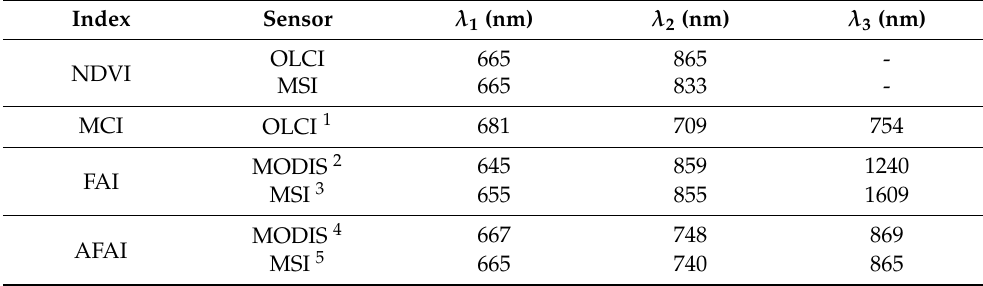
Table 2. Wavelength parameters of Equations (1) and (2) for NDVI, MCI, FAI and AFAI indexes for OLCI, MSI and